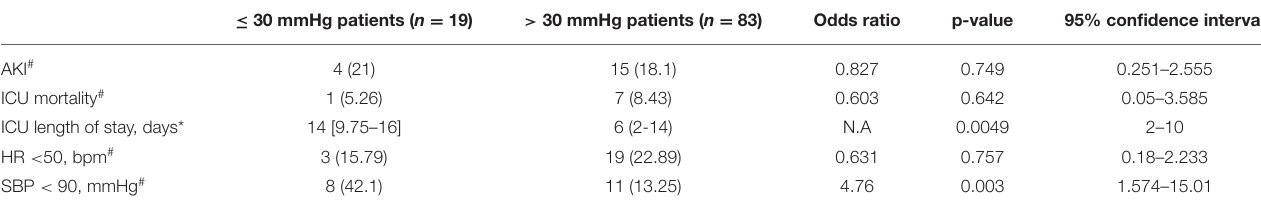
TABLE 2 | Comparison of outcomes between patients with SBP variability of ≤ 30 mmHg vs. > 30 mmHg. ≤ 30 mmHg patients ( n =